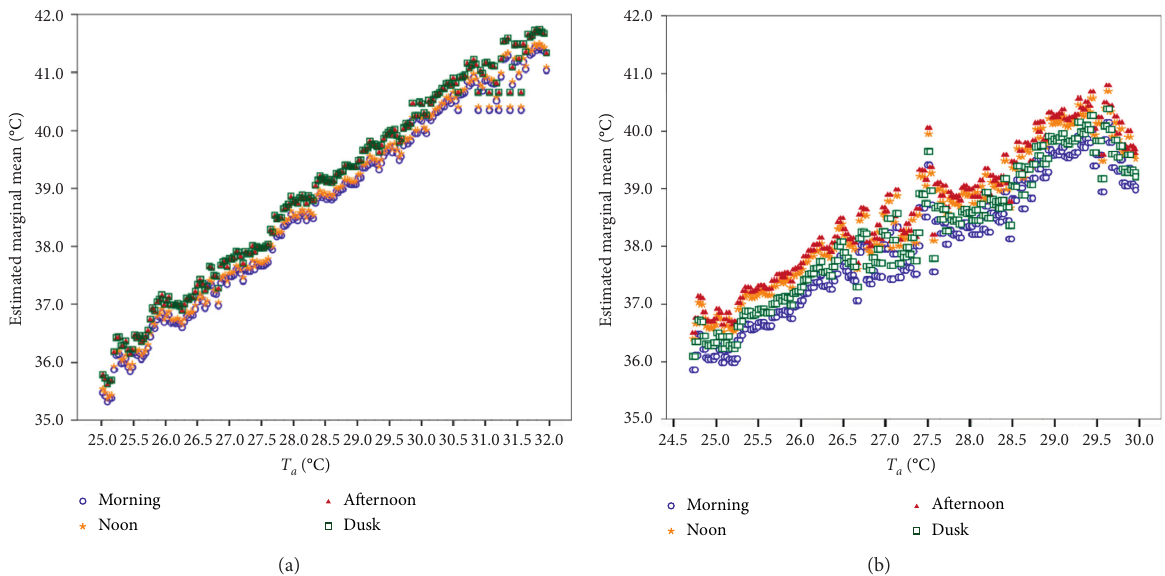
Figure 12: Estimated marginal mean LT